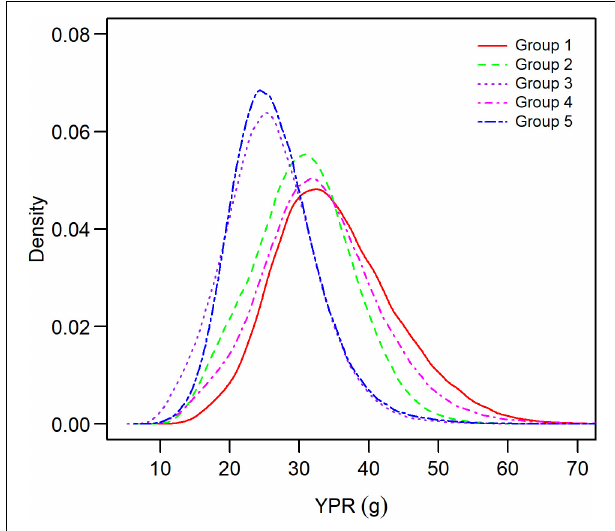
FIGURE 7 | Distribution of maximum yield-per-recruit for each group of small yellow croakers when t max = 3 years.